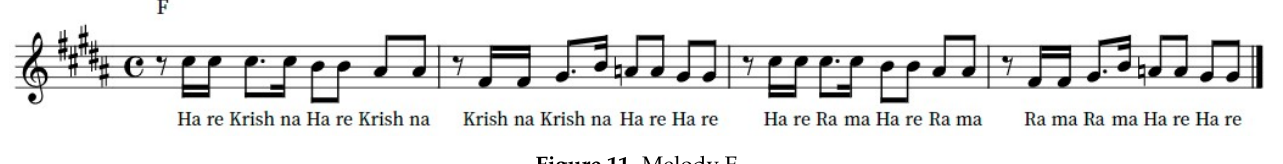
Figure 11. Melody Figure 11. Melody F.